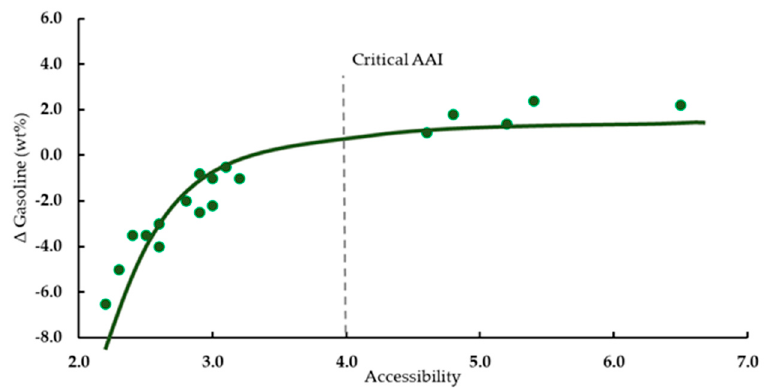
Figure 11. Effect of FCC accessibility on gasoline yield.